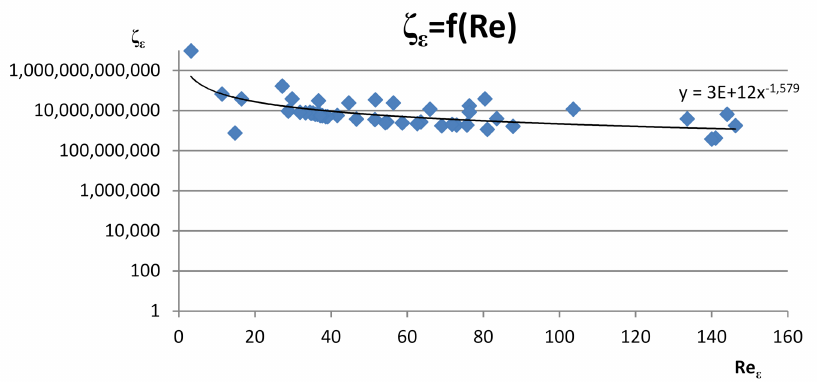
Figure 12. Influence of the Reynolds number on the biogas drag coefficient downwards for the adhesive deposit (own